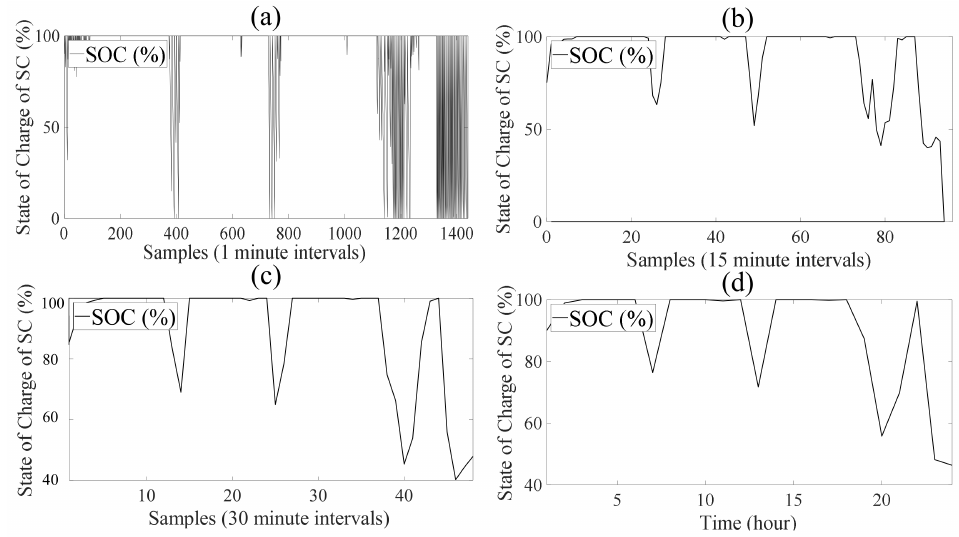
Figure 8. State of charge in SC. Data sampling at different time intervals: ( a ) 1 min, ( b ) 15 min, ( c ) 30 min and ( d ) every